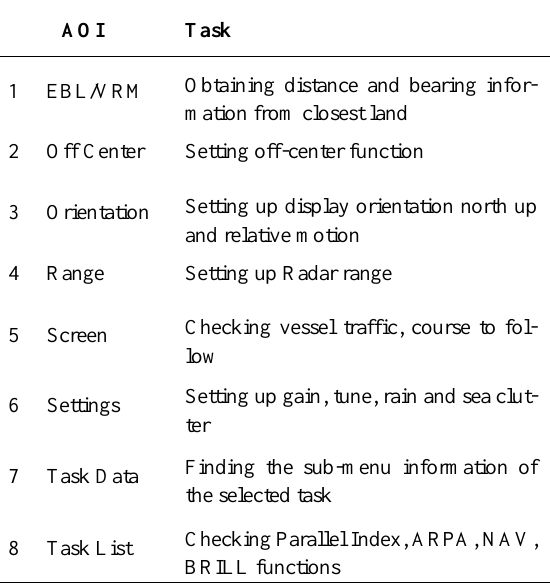
Table 3. List of areas of interest and corresponding tasks for radar exercise.